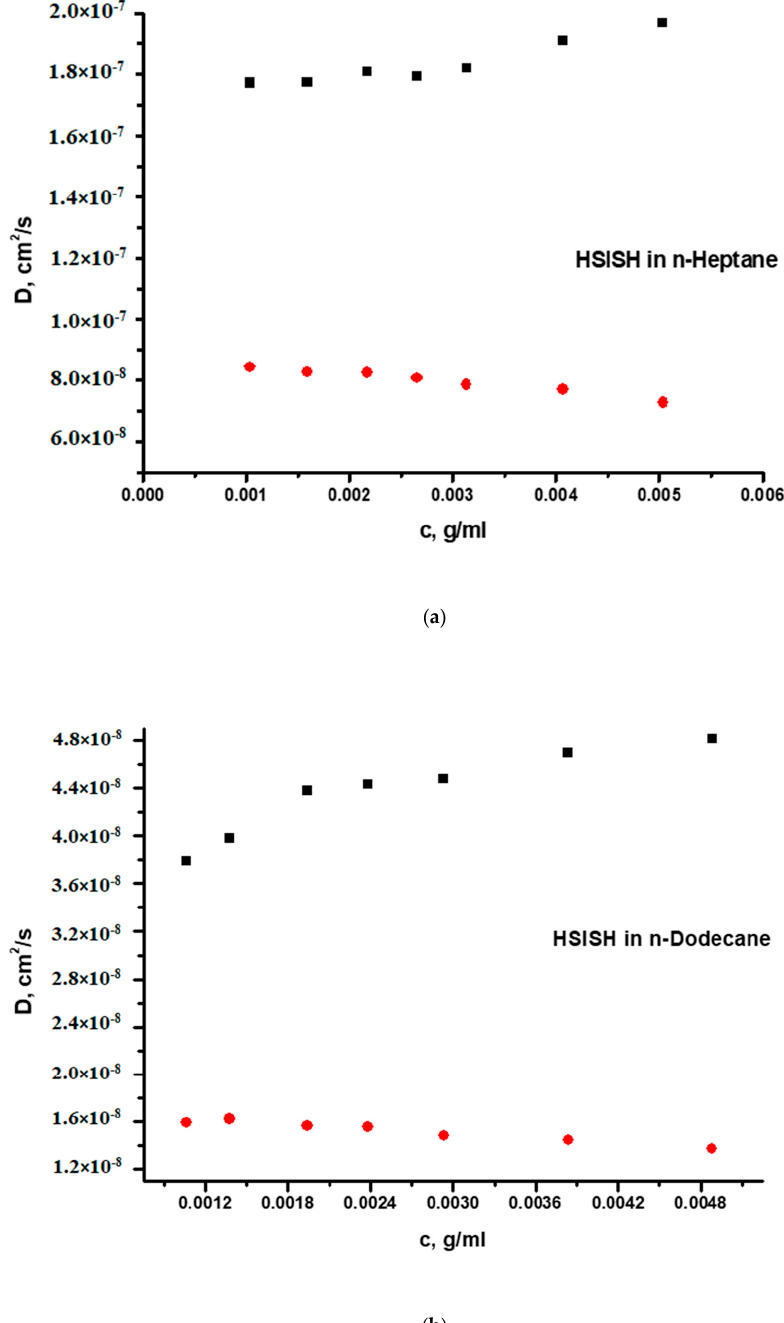
Figure 4. ( a ) DLS plots of the two populations of the HSISH pentablock terpolymer in n-heptane and ( b ) DLS plots of the two populations of the HSISH pentablock terpolymer in n-dodecane.